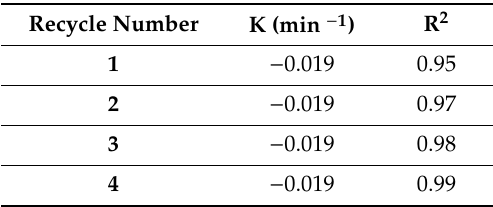
Table 4. The kinetic constants of recycle stability of the photocatalytic decomposition of MB under UV LED.